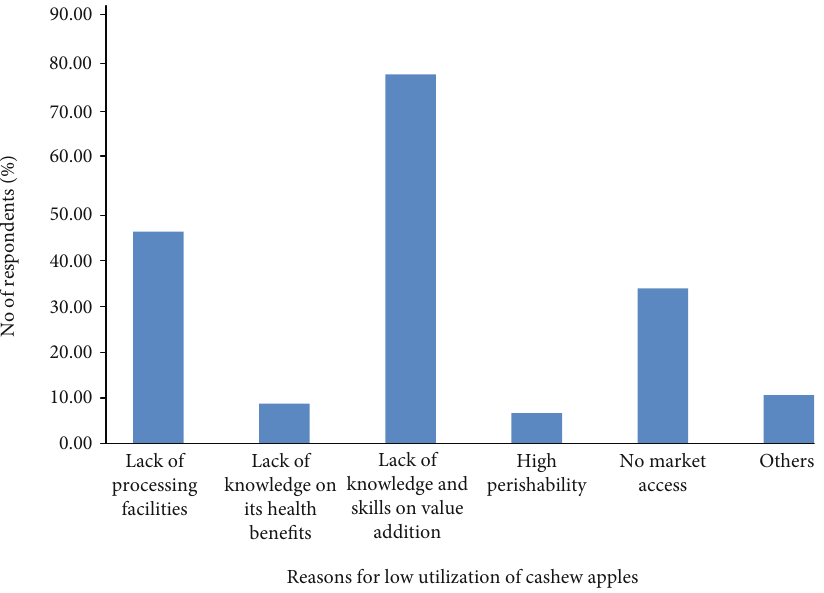
Figure 7: Challenges of cashew apple utilization in Ghana. Note: others refer to responses outside the thematic